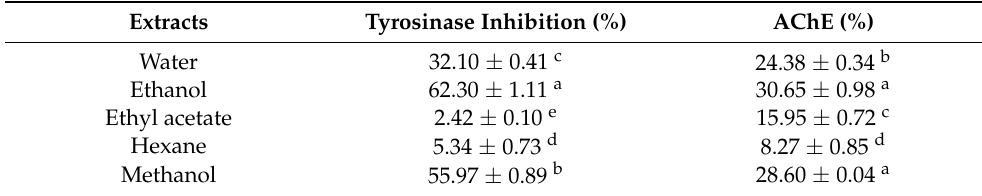
Table 6. Enzyme inhibition percentage of various A. hendersonii leaf extracts.